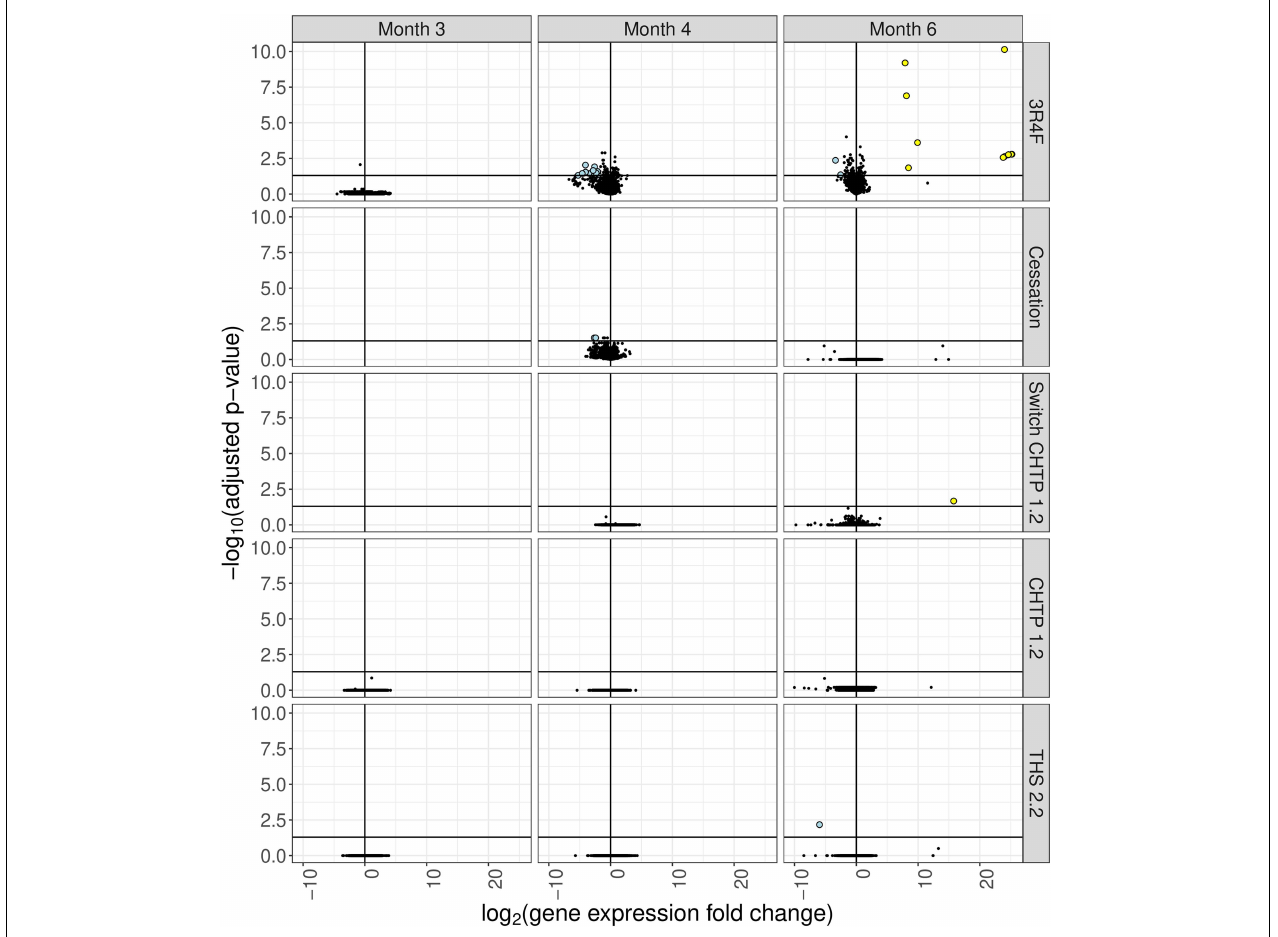
FIGURE 4 | Differential gene expression analysis of cecum tissue from mice in the various exposure groups, displayed as a “volcano plot.” Each data point corresponds to a gene, with the x-axis value being the log2 fold change in the exposure group relative to the sham group, and the y-axis being the negative log10 of the adjusted p value associated with the fold change. Points with adjusted p values <= 0.05 and an absolute expression fold change greater than 2 are rendered as large circles and are colored by whether they have an expression fold change less than –2 (light blue) or greater than 2